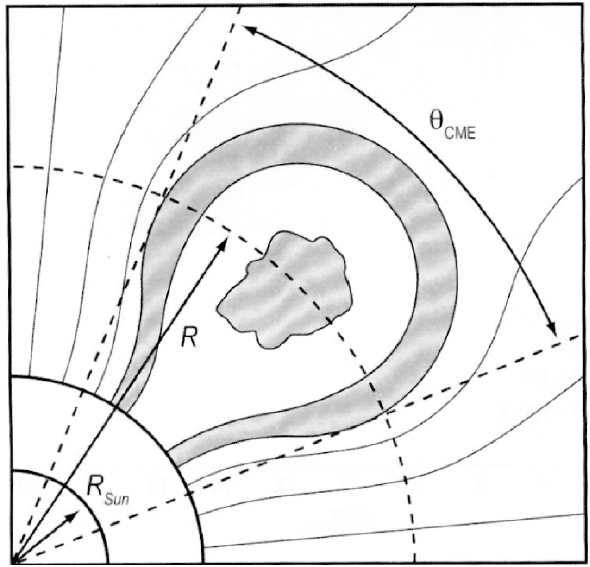
Fig. 11. From Moore et al. (2007) showing how the CMEs final angular width ( θ CME ) in the outer corona can be reasonably well estimated from the amount of magnetic flux covered by the source- region flare arcade due to the pressure balance of the CME with the surrounding magnetic field.